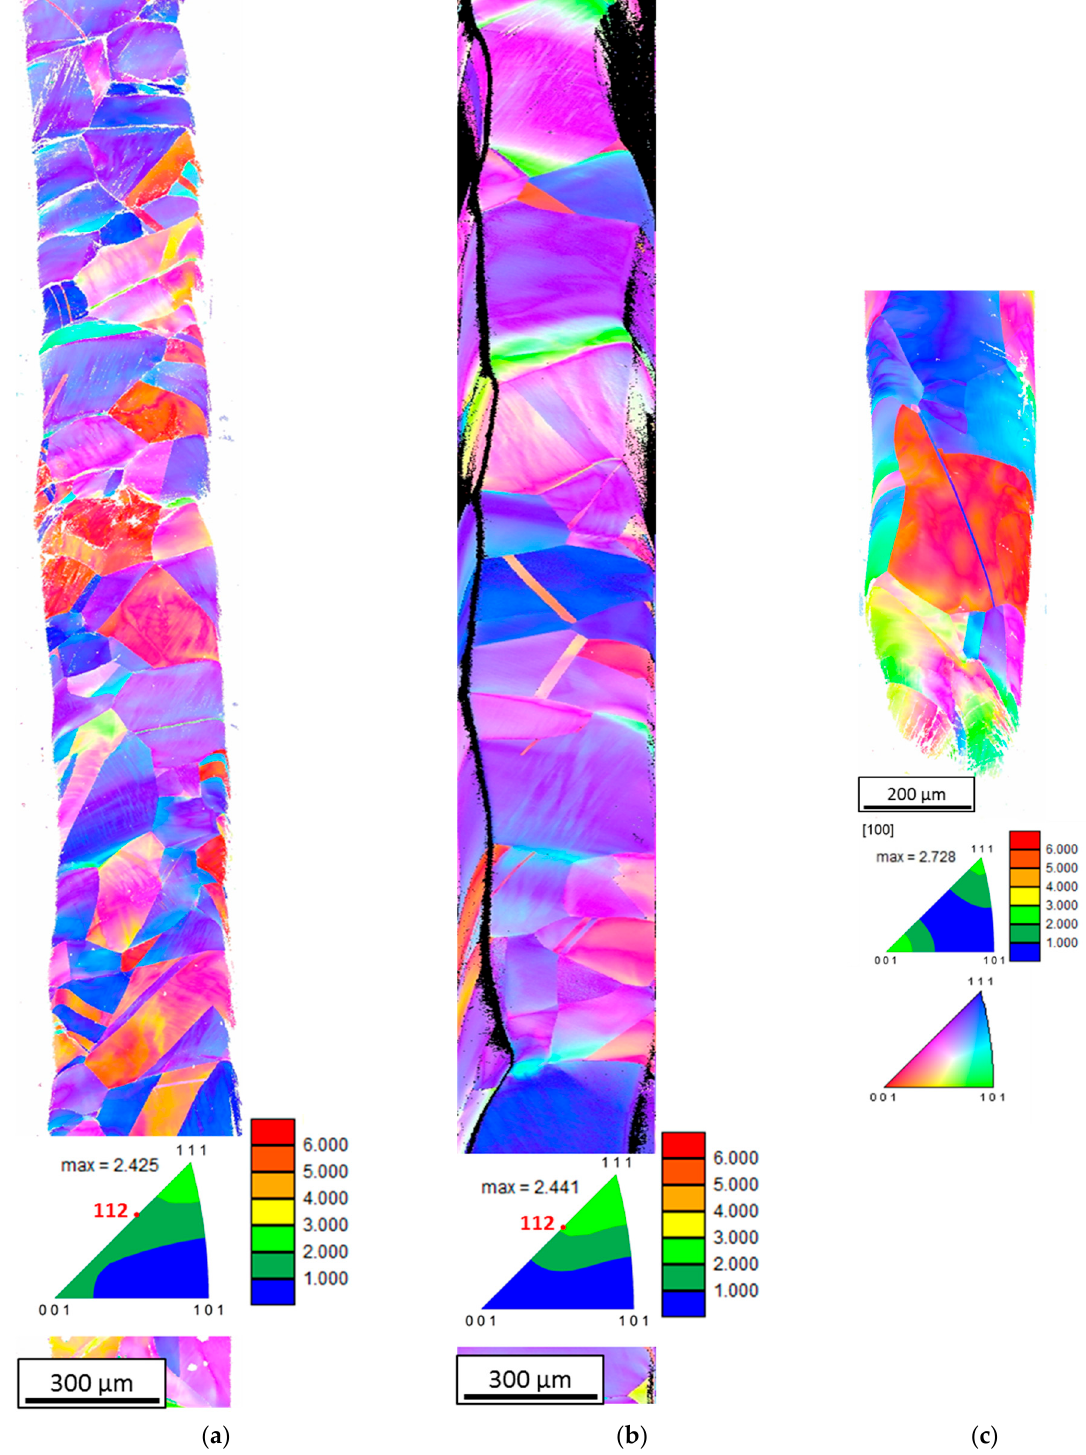
Figure 11. Inverse pole figure mappings of ( a ) solution annealed wire and ( b ) cold drawn wire (both fatigue tested wires without rupture) and ( c ) a solution annealed wire with fracture after only 500 cycles.